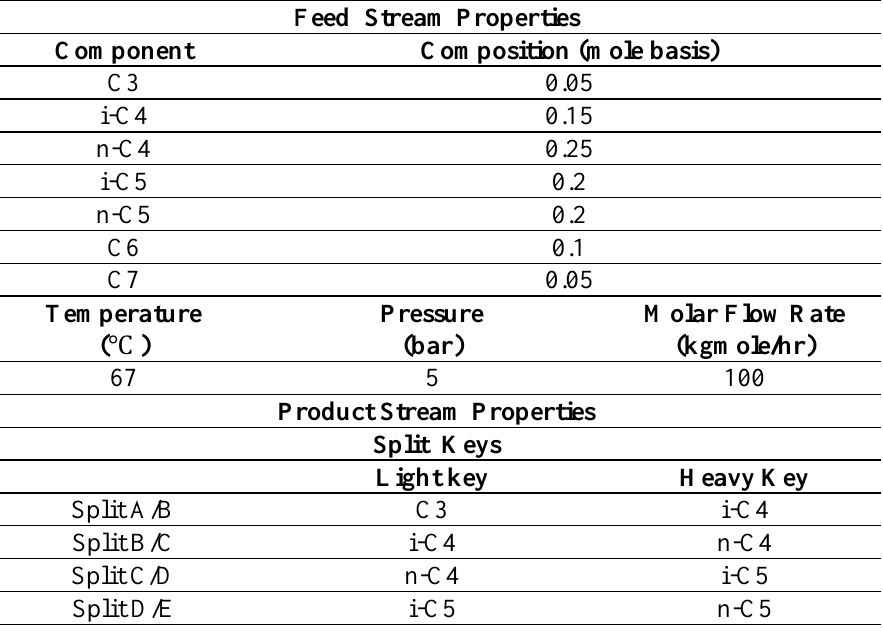
Table 3. Information of feed and product